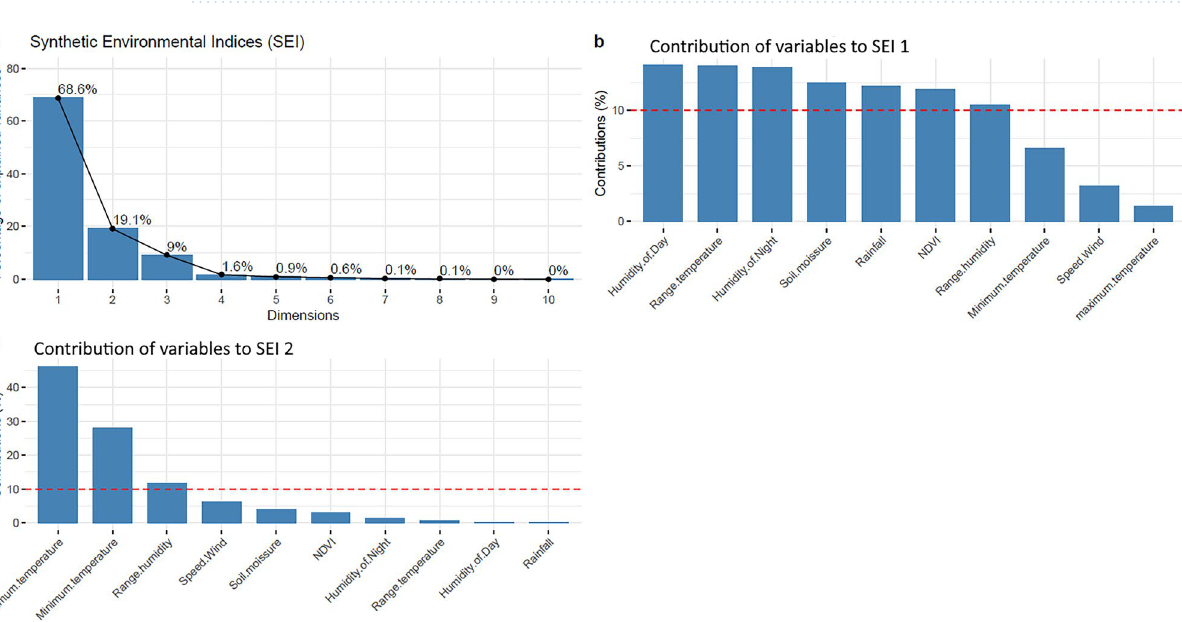
Figure 3. Synthetic indices resulting from the Principal Component Analysis of the different environmental variables. ( Panel a ) Two Synthetic Environmental Indices with 87.7% inertia. ( Panel b ) Synthetic Environmental Index 1 (rainfall, relative humidity, soil moisture, Normalized Difference Vegetation Index, and wind speed). ( Panel c ) Synthetic Environmental Index 2